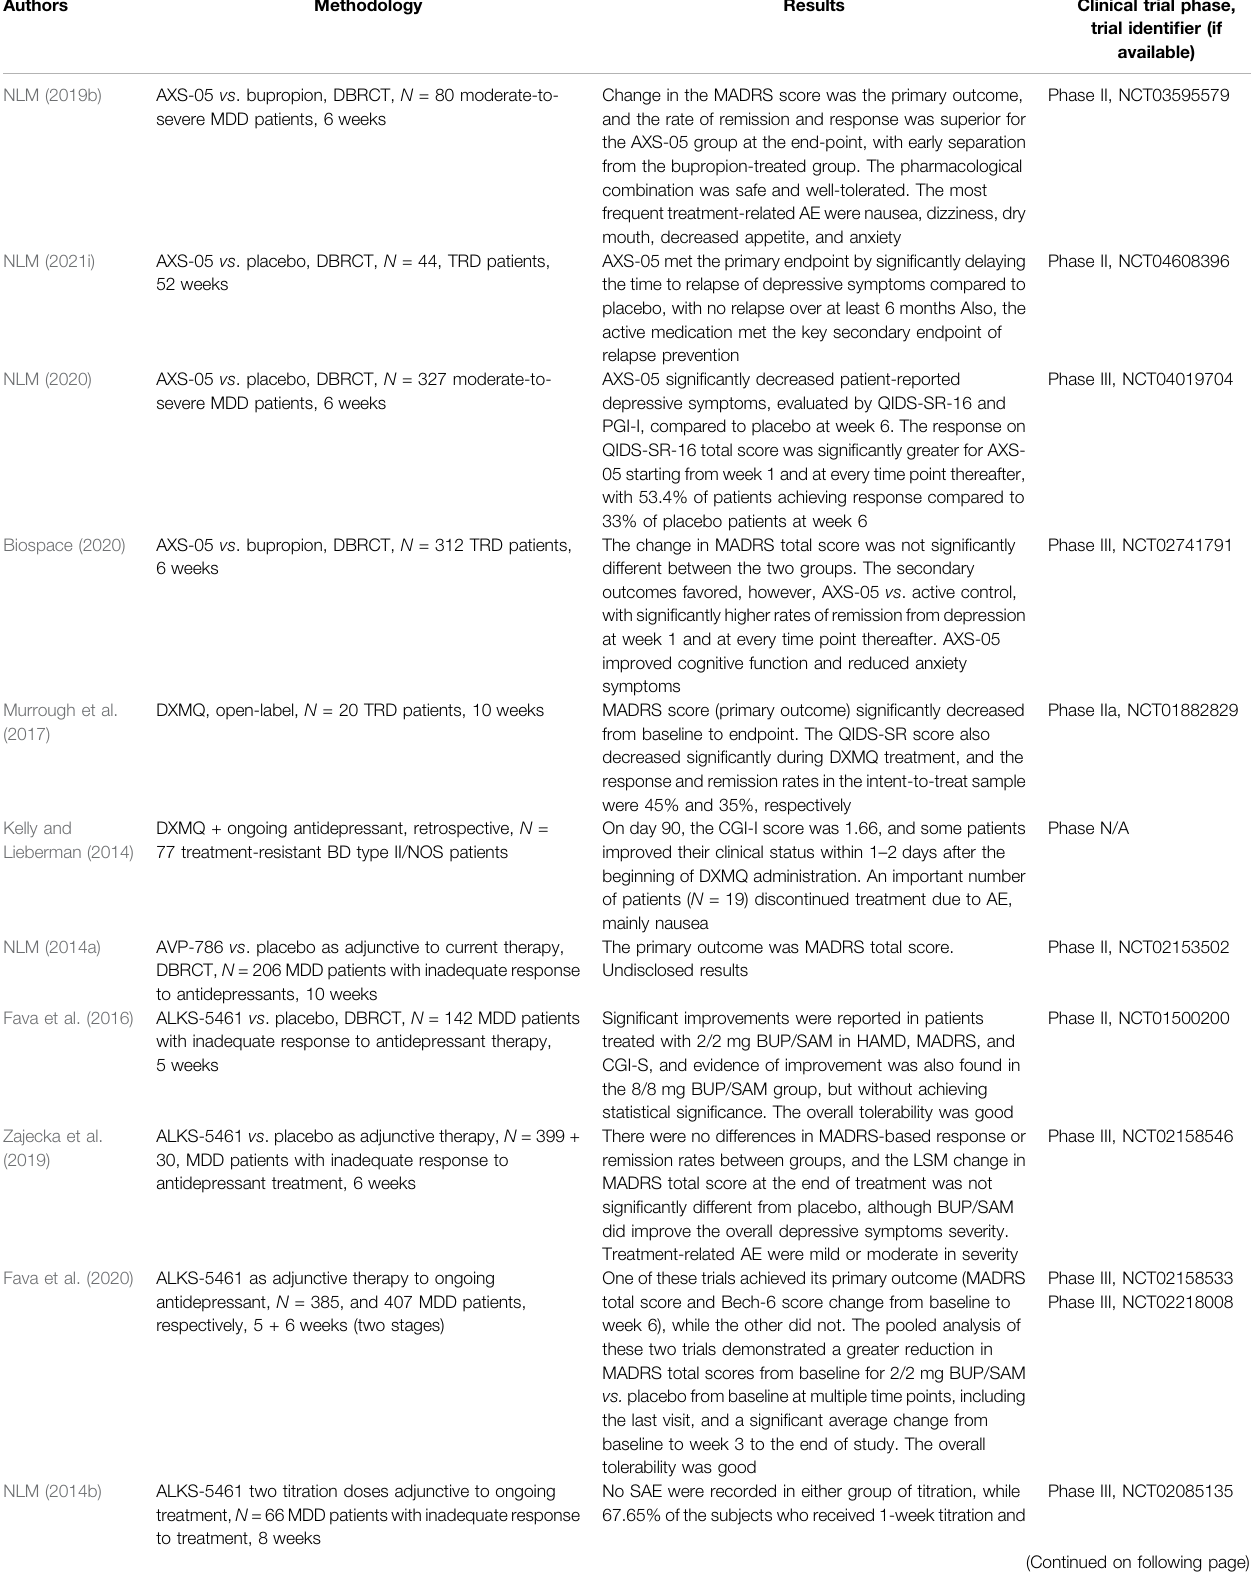
TABLE 3 | Combinations of pharmacological agents with antidepressant properties in the